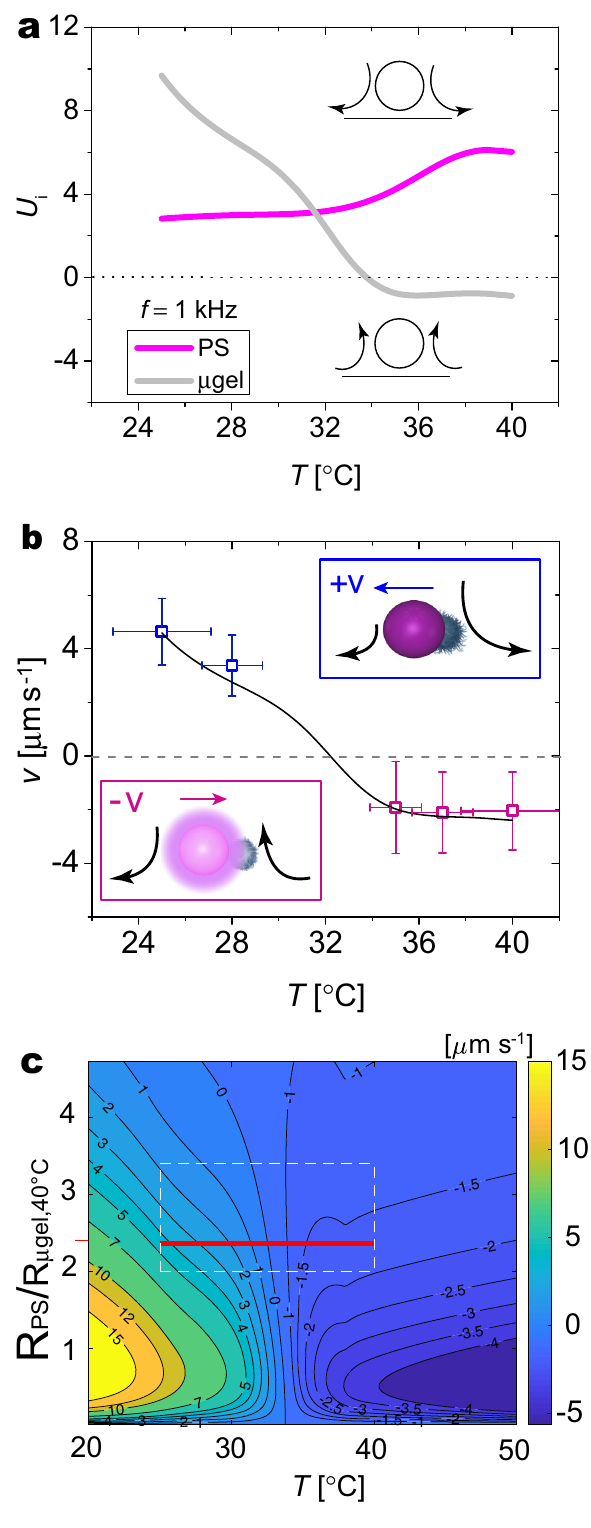
Fig. 4 Feedback between propulsion mechanism and particle recon fi guration. a EHDF velocities U i for each particle calculated from Eq. (1) with the fi tting parameters β 1 = 0.23 (PS) and β 2 = 4.4 (microgel). The schematics indicate the direction of the EHDFs, being either positive (repulsive) or negative (attractive). b Experimental values (symbols) and theoretical prediction (solid line) of dumbbell velocity as a function of temperature. The inset schemes indicate the EHD fl ows and fi nal propulsion direction. y-error bars are the standard deviation of the velocity calculated for 45 dumbbells at each temperature. x-error bars correspond to the uncertainty in experimentally determining T . c Theoretical prediction of dumbbell velocity v as a function of T and size ratio between the PS sphere and the collapsed microgel (at 40 °C). The plot is obtained from Eq. (1) using the experimental temperature-dependent system properties (particle size and dielectric properties, solvent viscosity) as inputs and a single-temperature independent prefactor. The dashed red box highlights the experimentally accessible range of T and size ratios (the range of size ratios is estimated from the error bars in Fig. 4b). The red solid horizontal line corresponds to the black solid curve in